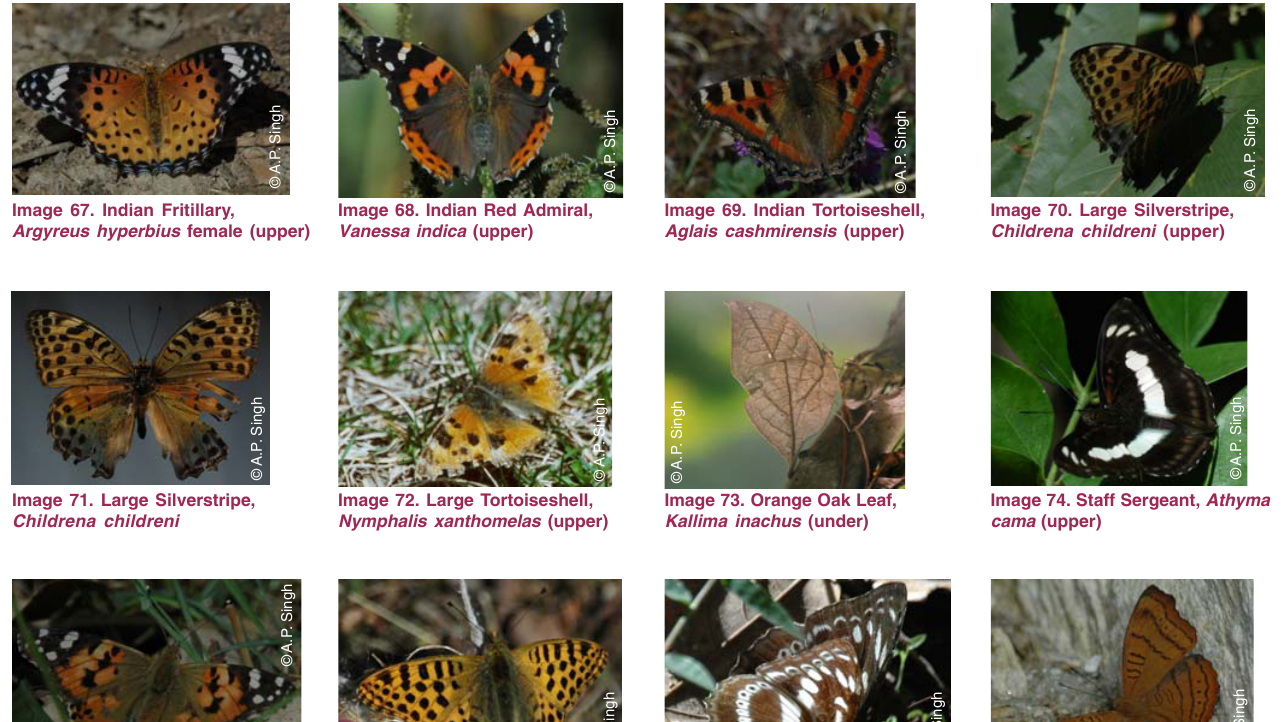
Image 75. Painted Lady, Cynthia cardui (upper)